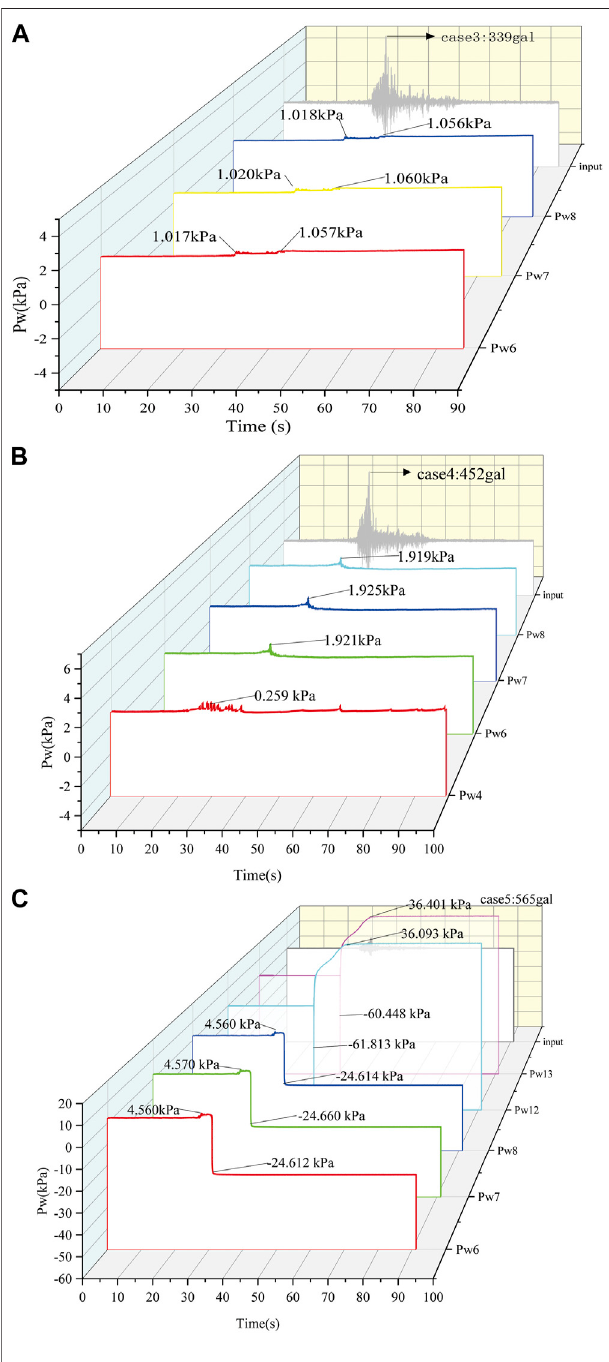
FIGURE 7 | The pore water pressure in the slope. (A) The input amplitude is 113 gal. (B) The input amplitude is 339 gal. (C) The input amplitude is 565